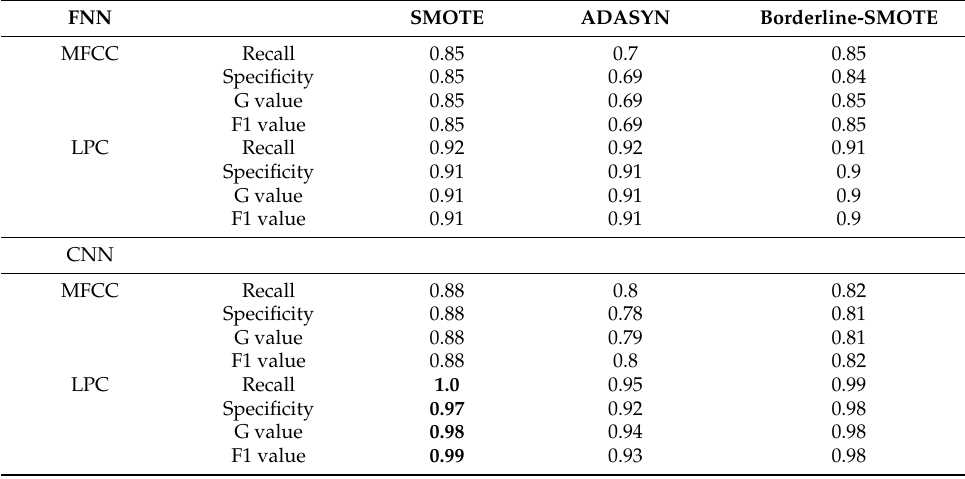
Figure 10. Performance comparison among various combinations of methods on the class-imbalanced and class-balanced dataset. Table 5. Evaluation measures produced by each model on the class-balanced